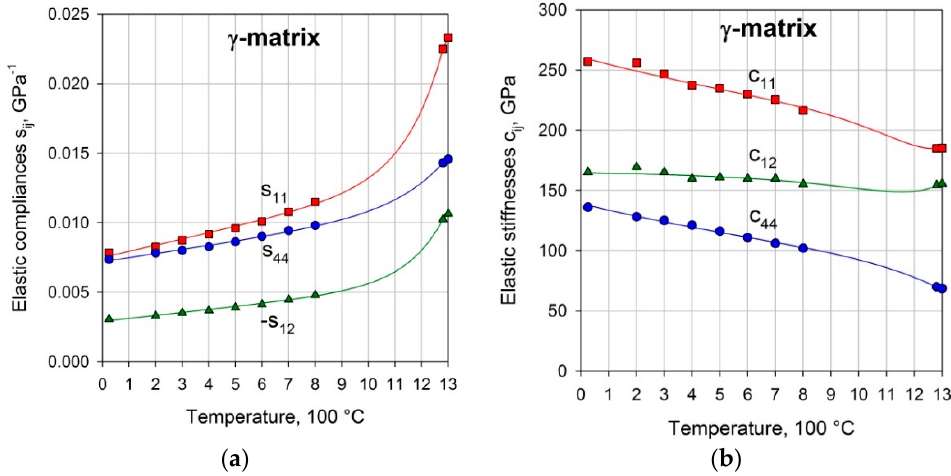
Figure 7. Elastic constants of the γ -matrix as functions of temperature. ( a ) Elastic compliances s ij , and ( b ) elastic stiffnesses c ij . Symbols indicate the measured values, and the lines indicate the curves fitted with Equation (11). The elastic constants of γ -matrix presented in the temperature range RT –800 ◦ C were measured in [16].